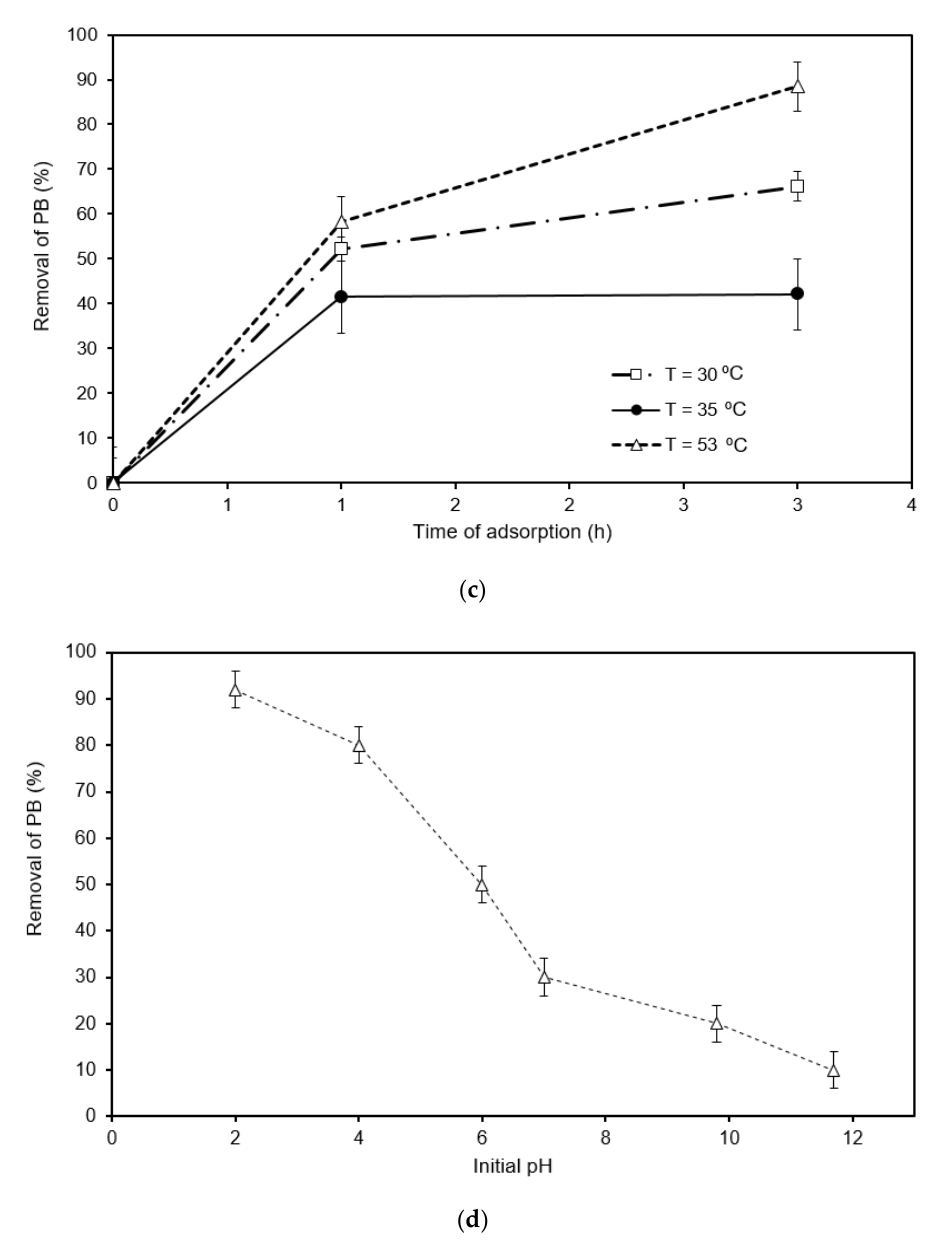
Figure 2. Effect of process parameters on the removal of PB dye using Sterculia alata biochar: ( a ) removal efficiency profiles; ( b ) decrease in PB dye concentration with a biochar dose of 4 g; ( c ) effect of temperature on PB dye removal at an initial concentration of 500 mg/L; ( d ) effect of pH on the removal efficiency of PB dye.